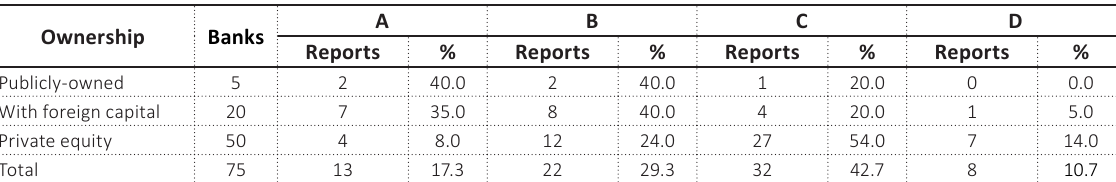
Table 4. Grouping of Ukrainian banks according to the value of the Q&C BMR index and the type of